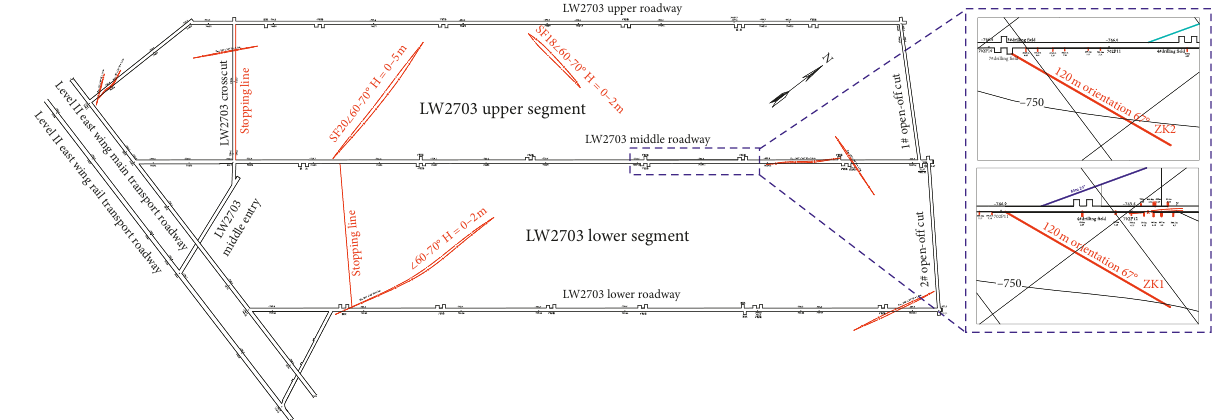
Figure 2: LW2703 working face